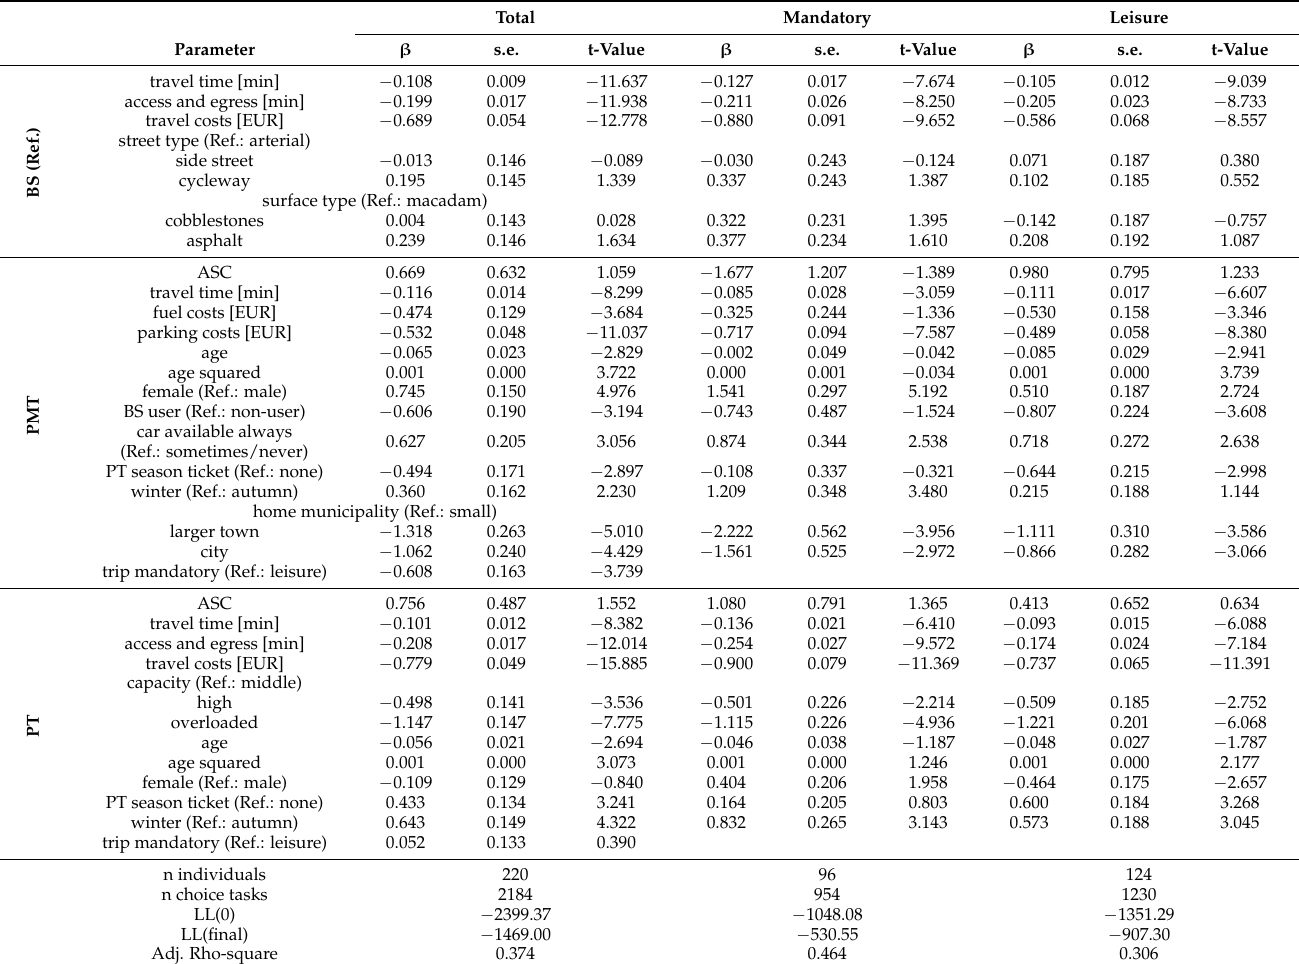
Table 6. Results of MNL models for all observations (total) and trip specific